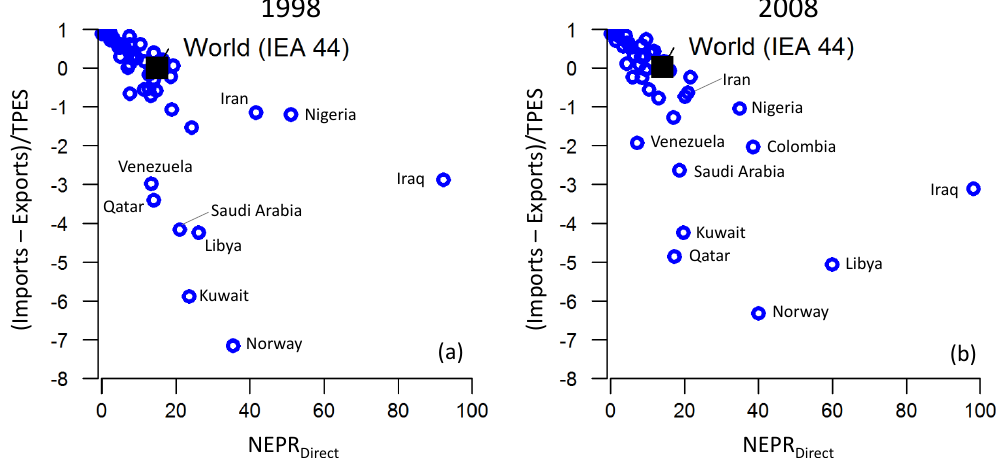
Figure 8. Countries that are net energy importers have lower NEPR direct . Data are shown for two years: ( a ) 1998, the year of the least expensive energy in the data; and ( b ) 2008, a year with relatively expensive energy. The y-axis indicates the ratio of net energy imports (in units of energy) divided by total primary energy supply (TPES). The large square represents the value for the 44-country world aggregate. Exports are assumed as a positive number, such that net (energy) exporting countries have negative values on the y-axis and net importing countries have positive values on the